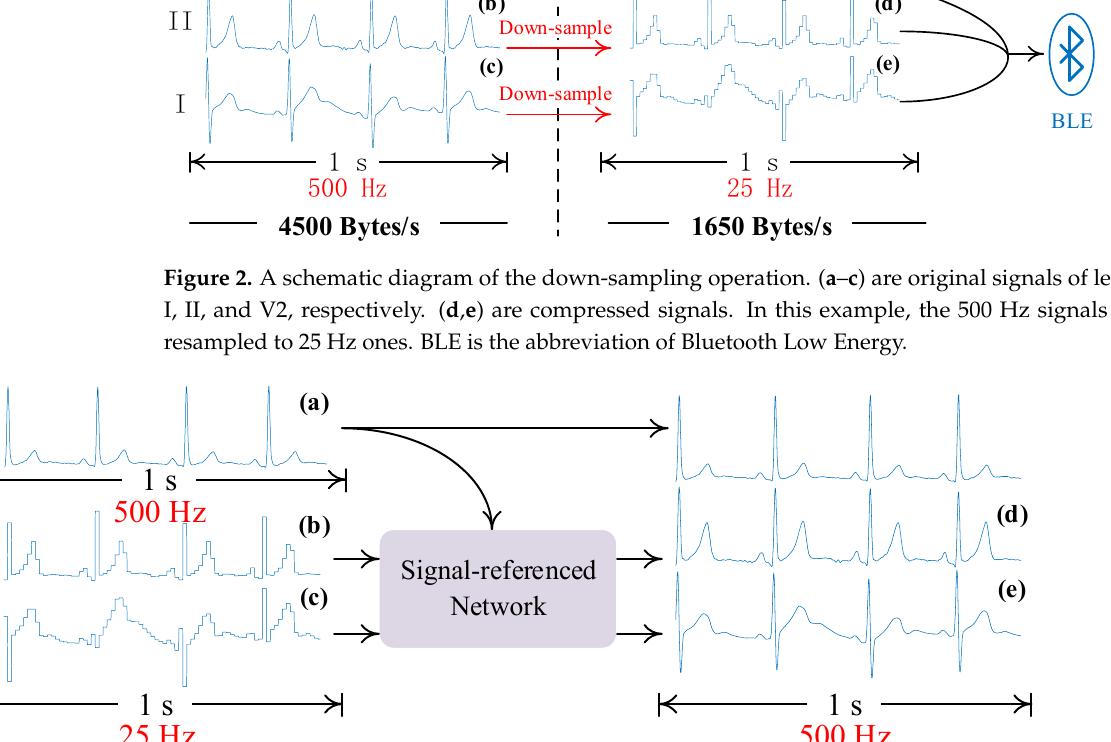
Figure 2. A schematic diagram of the down-sampling operation. ( a – c ) are original signals of leads I, II, and V2, respectively. ( d , e ) are compressed signals. In this example, the 500 Hz signals are resampled to 25 Hz ones. BLE is the abbreviation of Bluetooth Low Energy.